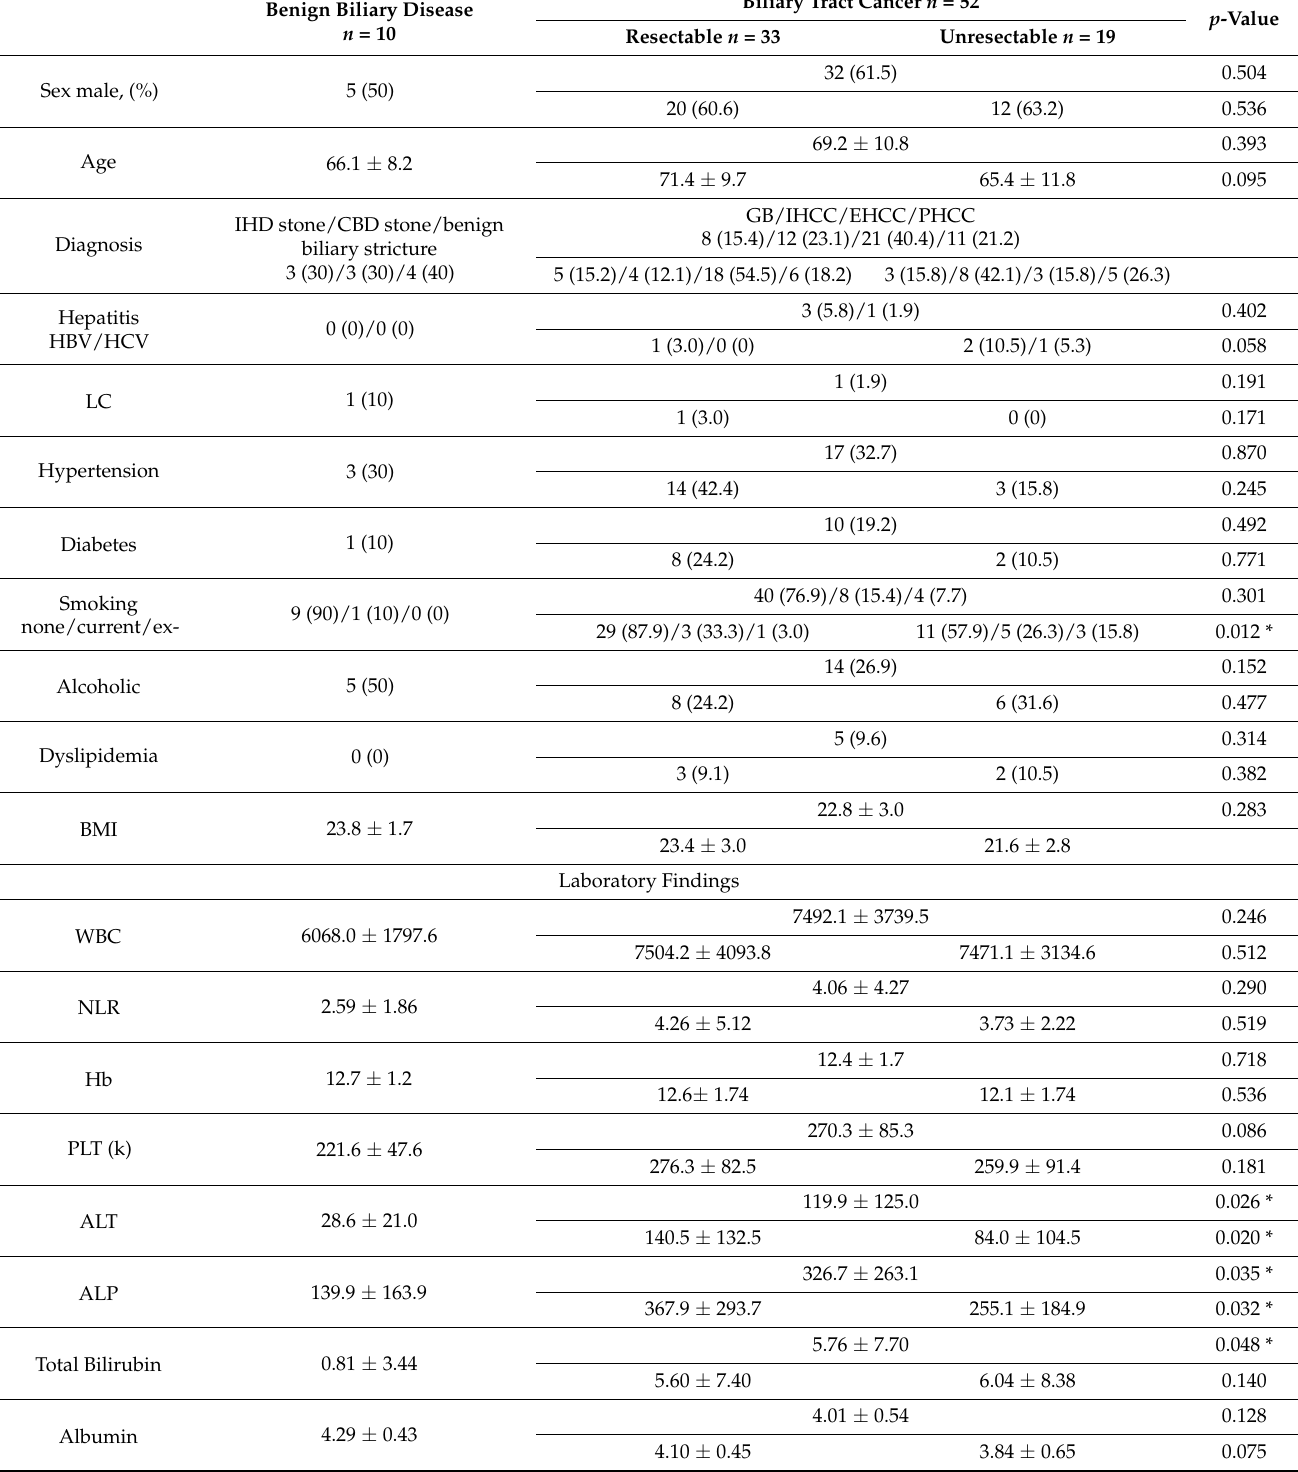
Table 1. Patient characteristics and CTC counts/v-CTC